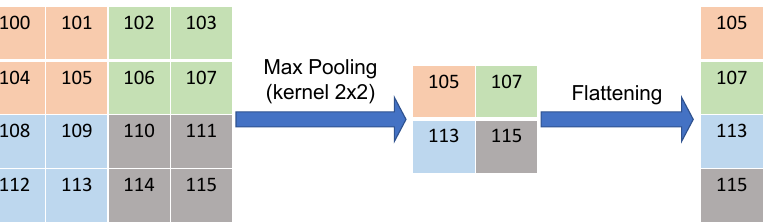
Figure 7. An example of max pooling in CNN with a 2 × 2 kernel size and the flattening